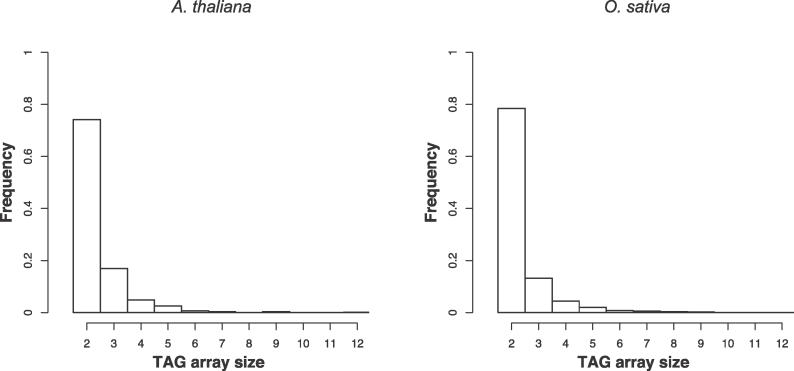
Distribution of the Size of TAGs for the H/0 Dataset(A) A. thaliana. (B) O. sativa.